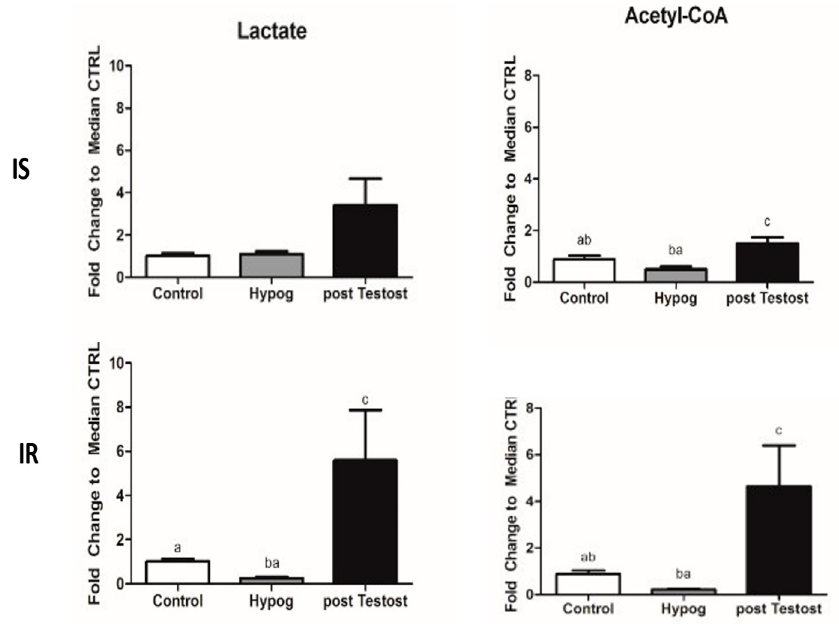
Figure 4. Lactate and acetyl-CoA changes in control and hypogonadism subjects, before and after TRT. The data shown are from previous published papers